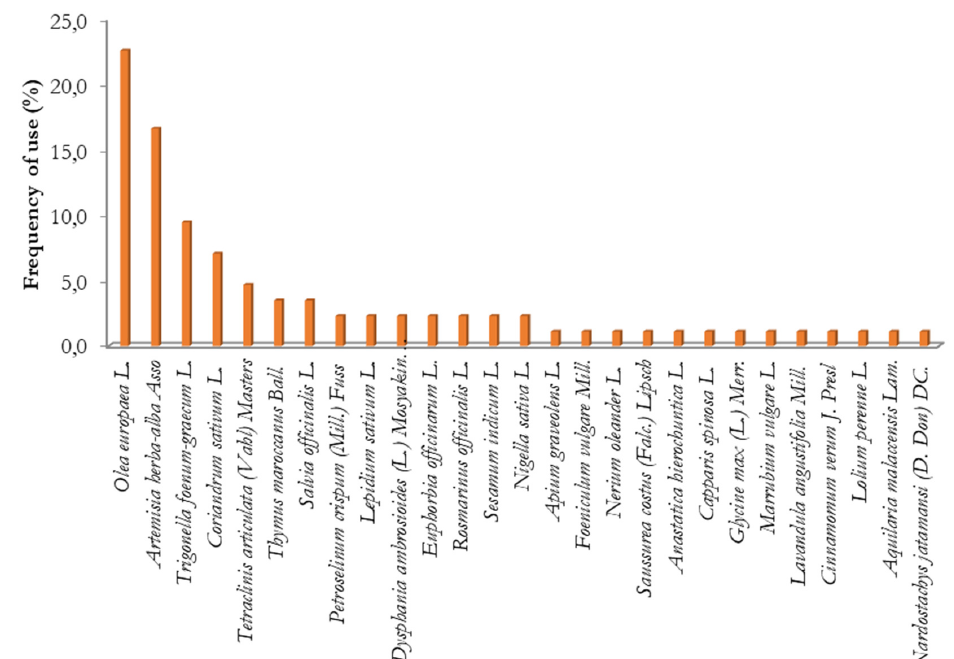
Figure 4. Types of herbal medicines used by respondents